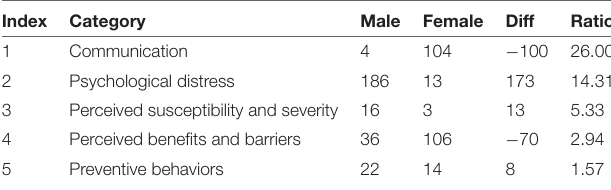
TABLE 4 | Comparison of total association rules between gender